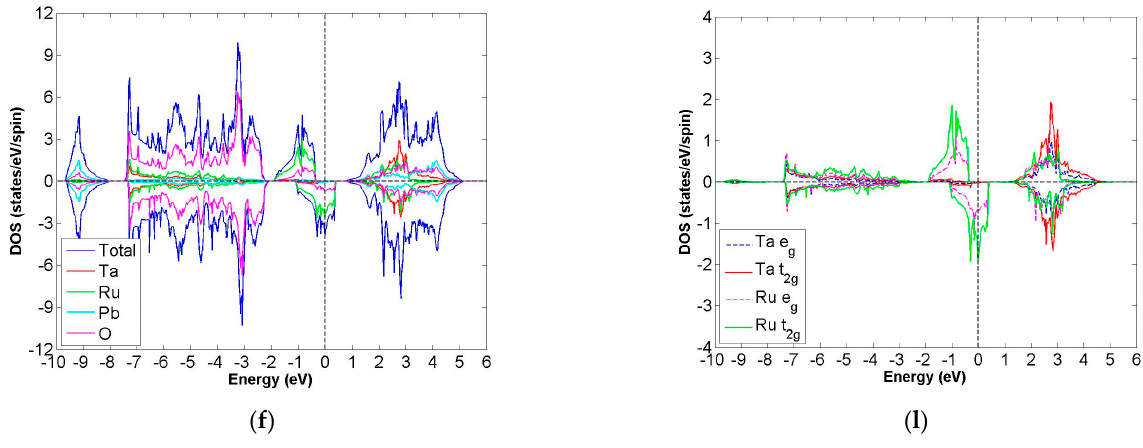
Figure 6. Under GGA + U (U of Ti, Zr, Hf, V, Nb, Ta and Ru set up as 2) schemes, the calculated total and partial DOS values of ( a ) Pb 2 TiRuO 6 , ( b ) Pb 2 ZrRuO 6 , ( c ) Pb 2 HfRuO 6 , ( d ) Pb 2 VRuO 6 , ( e ) Pb 2 NbRuO 6 and ( f ) Pb 2 TaRuO 6 and the partial DOS of e g and t 2g spin orbitals for ( g ) Ti and Ru, ( h ) Zr and Ru, ( i ) Hf and Ru, ( j ) V and Ru, ( k ) Nb and Ru, ( l ) Ta and Ru.